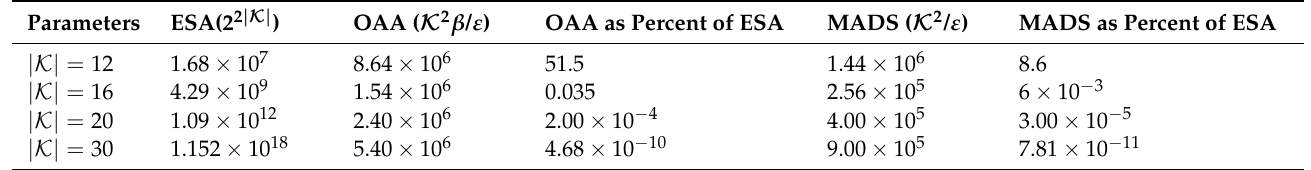
Table 2. Complexity Comparison (number of flops).